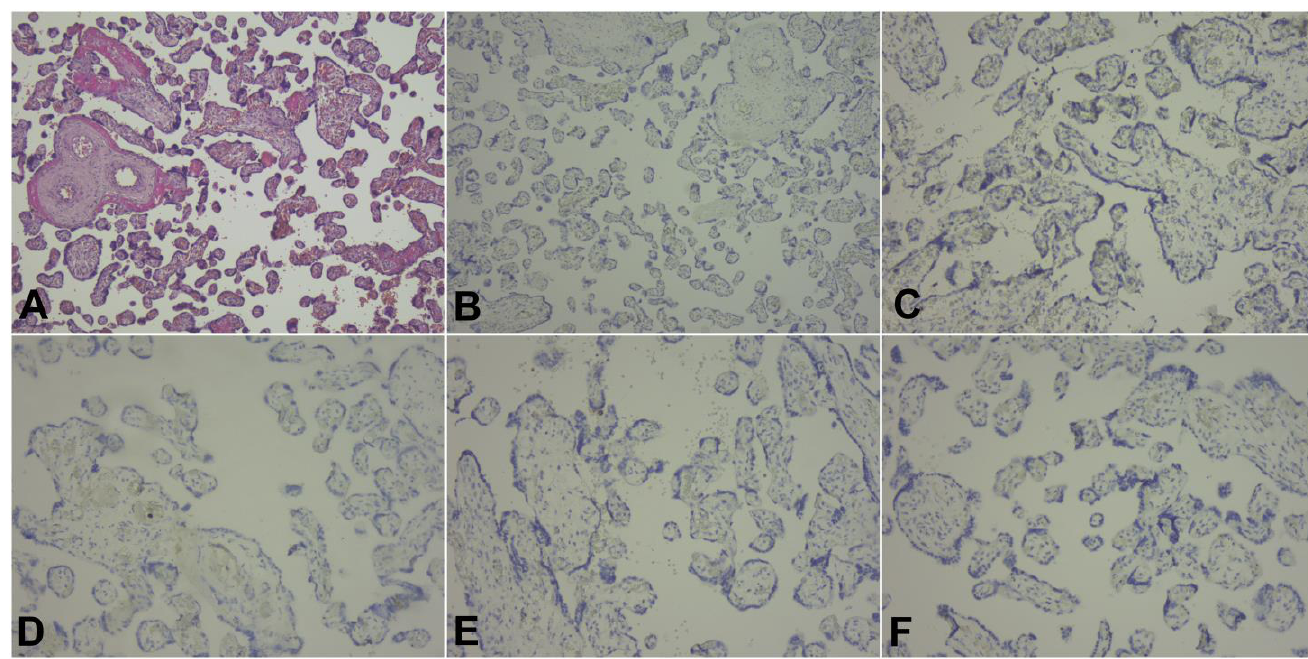
Figure 1. Selected microscopic aspects from placental sections: ( A ) Presence of intramural fibrin deposition and lack of inflammatory cells, H&E stain, ×100 magnification. ( B – F ) Negativity for the immune markings: ( B ) CD4, ×100 magnification, ( C ) CD8, ×200 magnification, ( D ) CD19, ×200 mag-